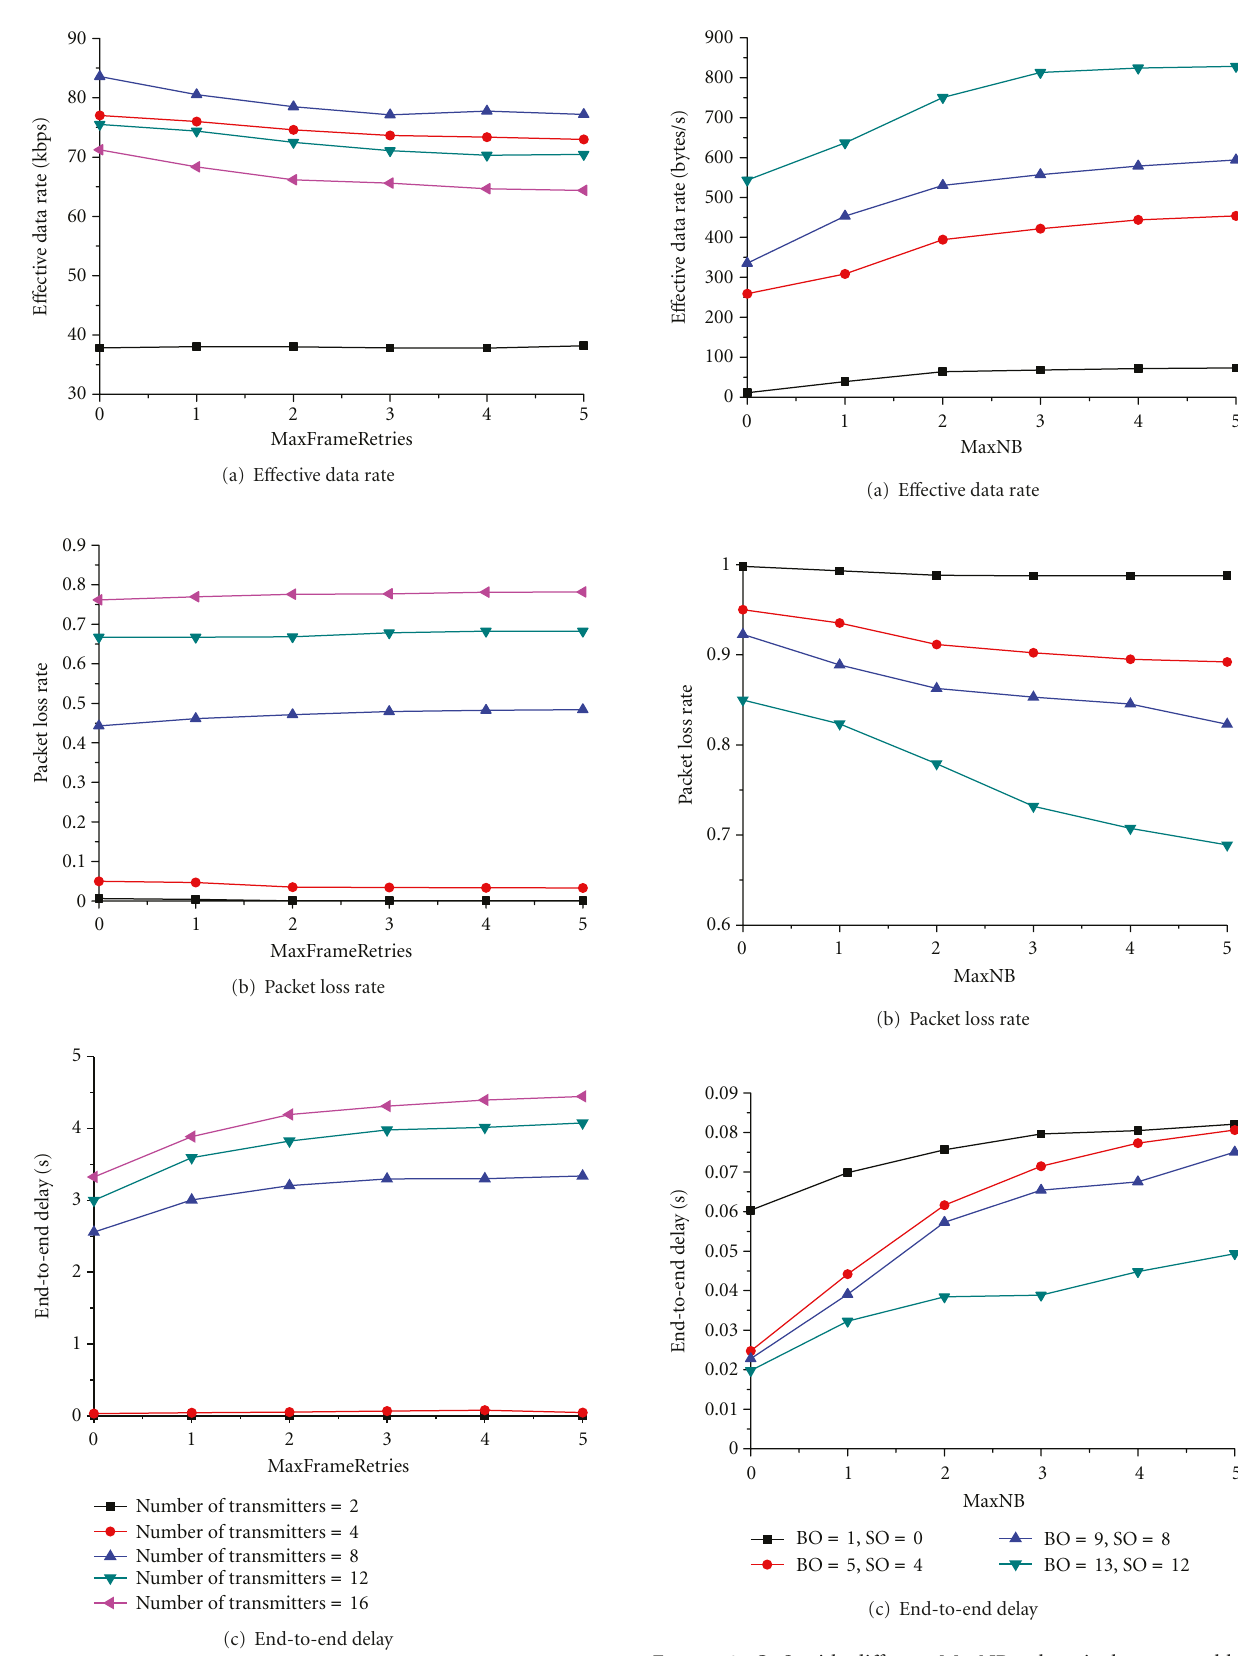
Figure 7: QoS with di ff erent MaxFrameRetries values.